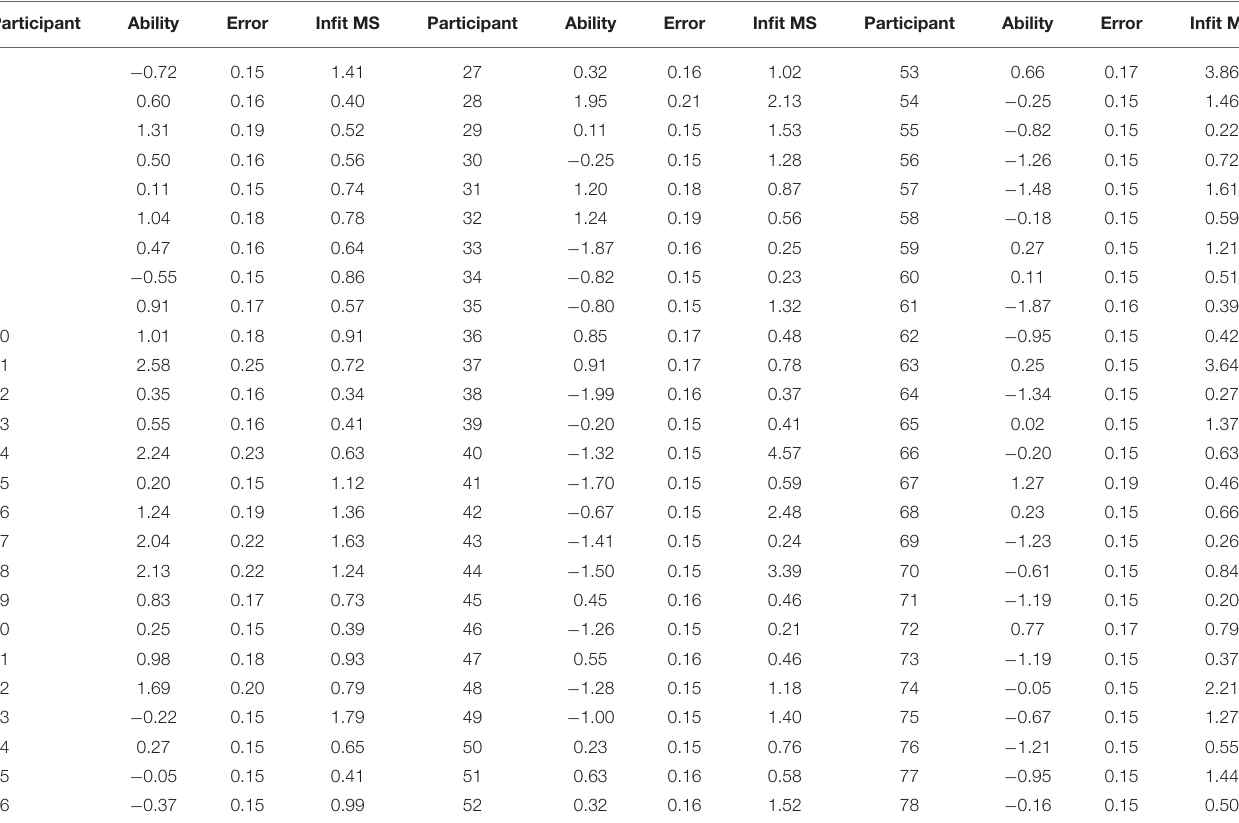
TABLE 4 | FACETS analysis of the ability of candidates.